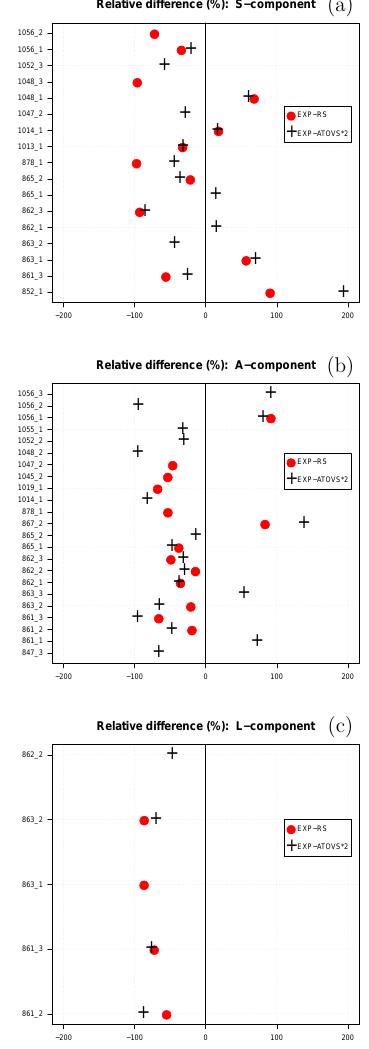
Fig. 12. Case-by-case relative difference of the three components S , A and L . X axes depict cases and y axes relative differences. Rows correspond to S , A and L ( a–c , respectively). Relative differences (with respect to EXP) for EXP-RS (red dots) and EXP-ATOVS*2 (black